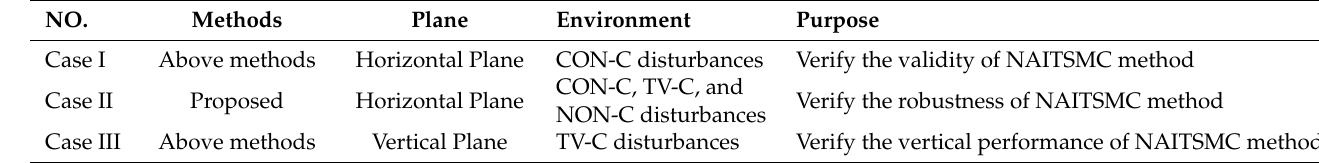
Table 1. The simulation cases.